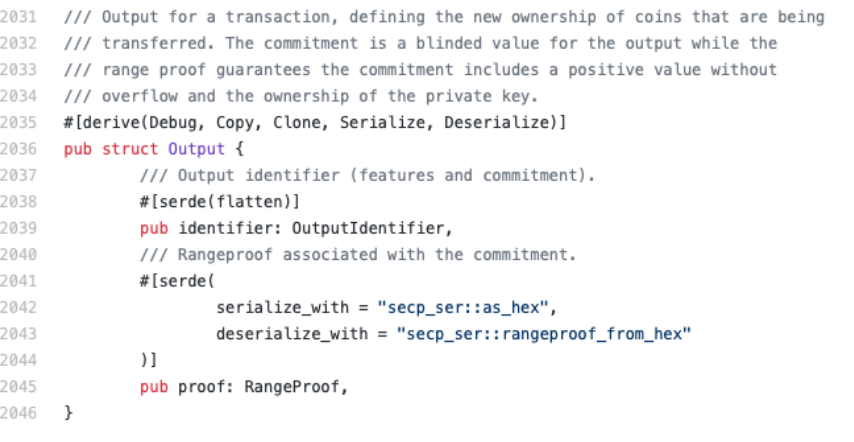
Figure A3. Grin output source code [63].